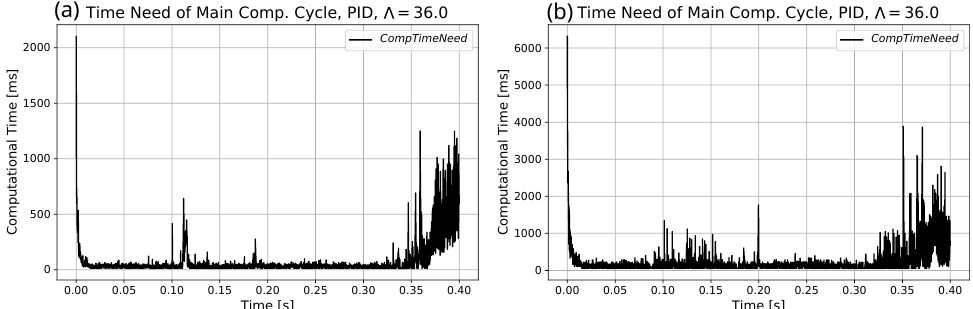
Figure 14. The adaptive abstract rotations. ( a ) For set 1. ( b ) For set 2.